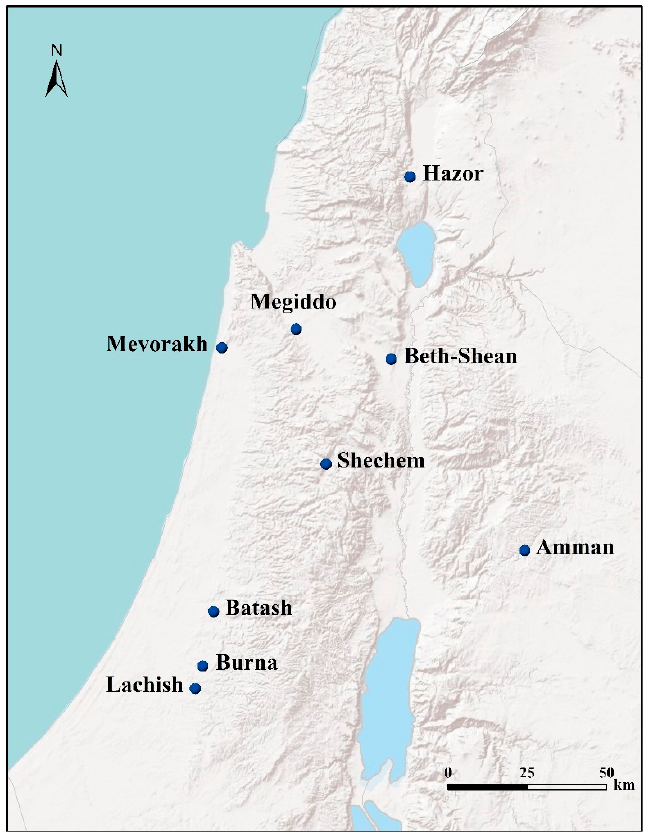
Figure 1. Late Bronze Age sites mentioned in the text (Prepared by H. Cohen-Klonymus).